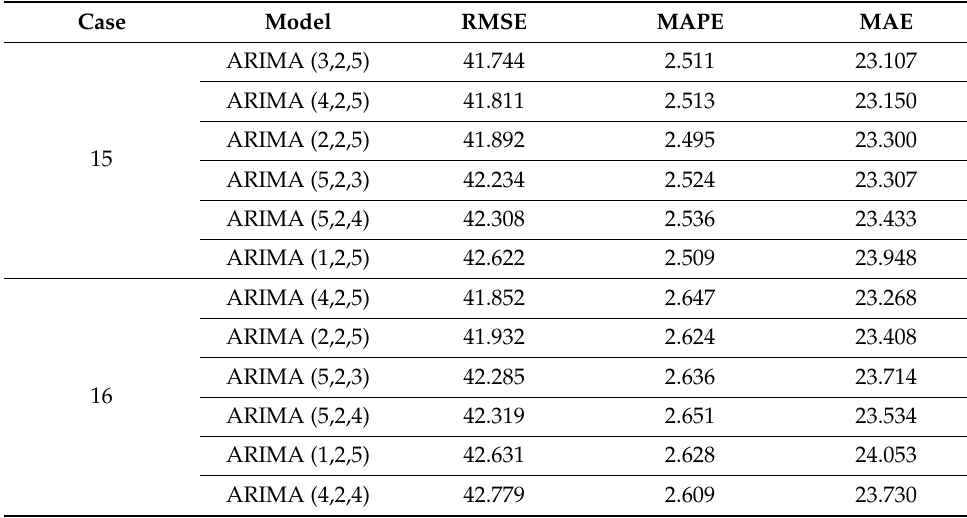
Table 7. Results of ARIMA models for Group 5 (case